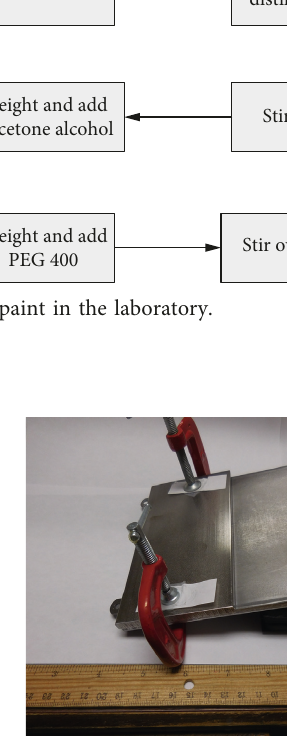
Figure 2: Camber sorter. A substrate is slid down the bottom plate through the gap to the end of the two metal plates. The smallest gap distance a substrate passes through is D (Equation